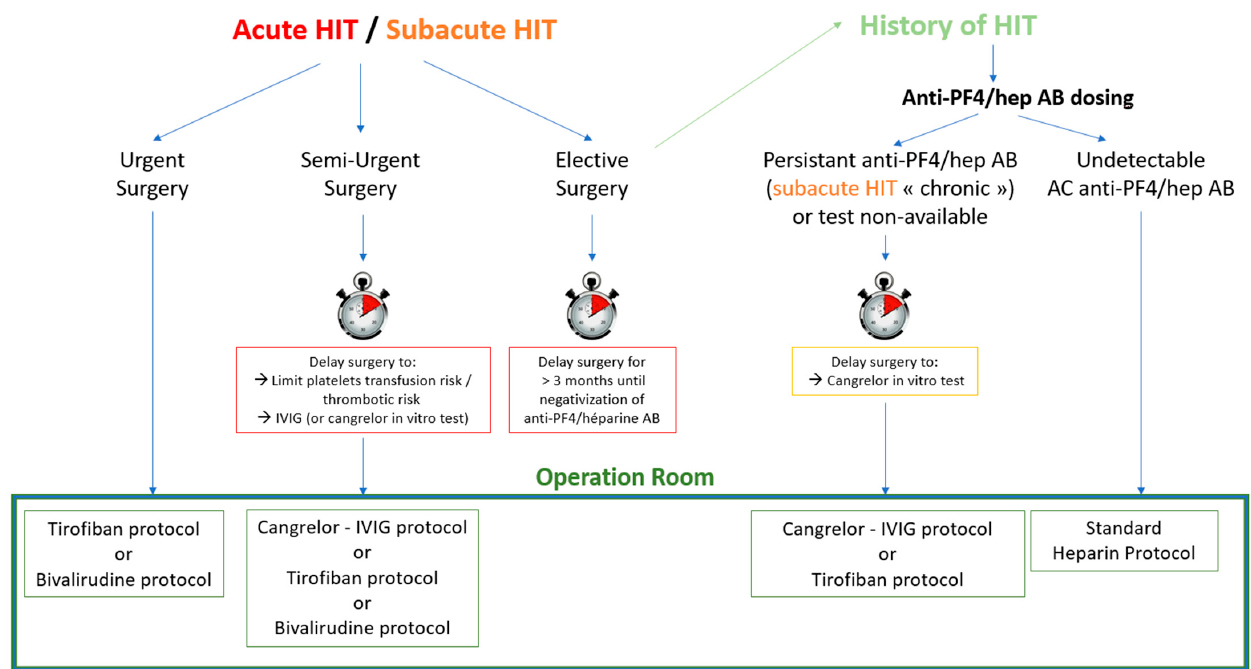
Figure 3. Institutional protocol describing procedure and protocol depending on HIT phase and surgical timing. surgical